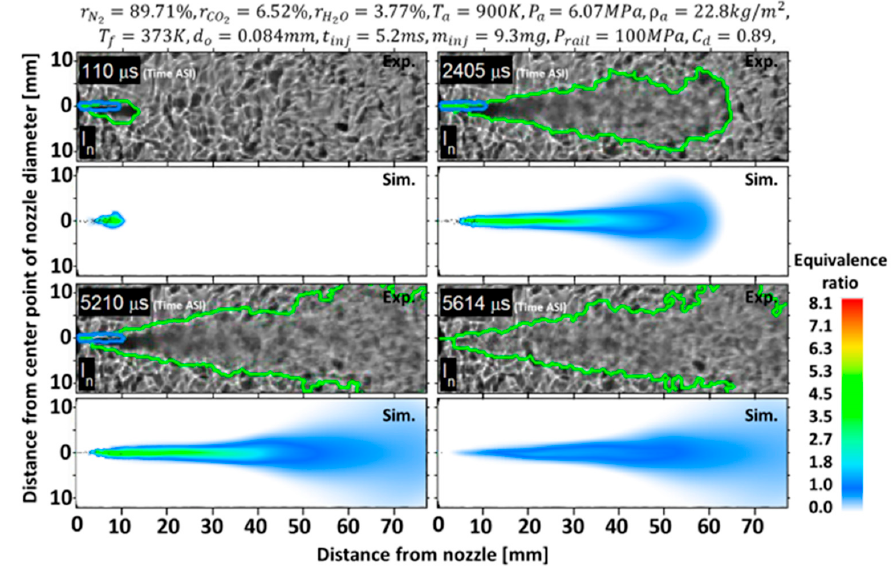
Figure 7. Comparison of the spray shapes and the equivalence ratio histories of the